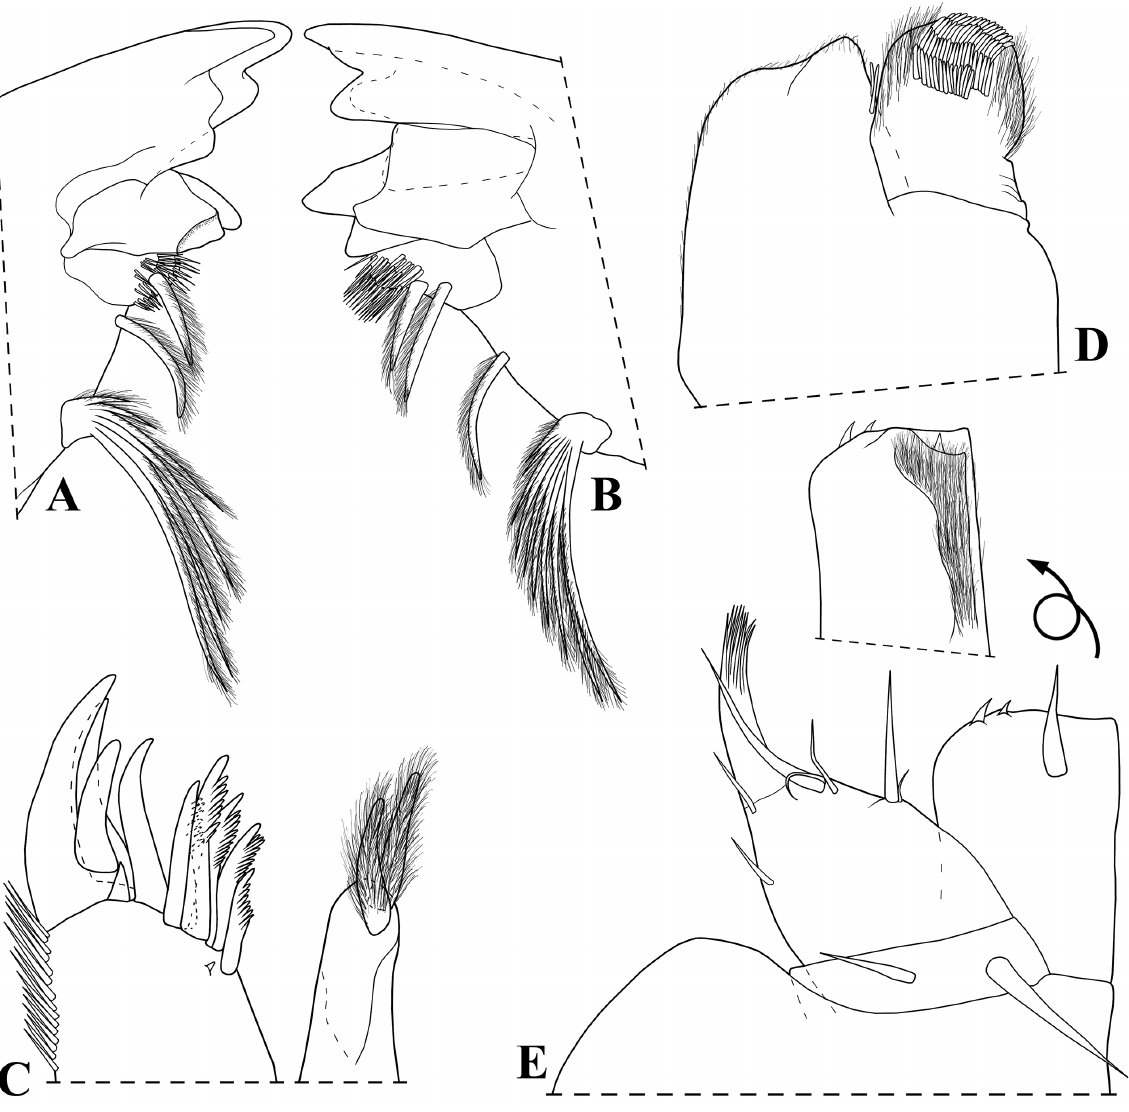
Fig. 3. Alboscia jotajota Campos-Filho, Bichuette & Taiti sp. nov., ♀, paratype (LES 18852). A . Right mandible. B . Left mandible. C . Maxillula. D . Maxilla. E .